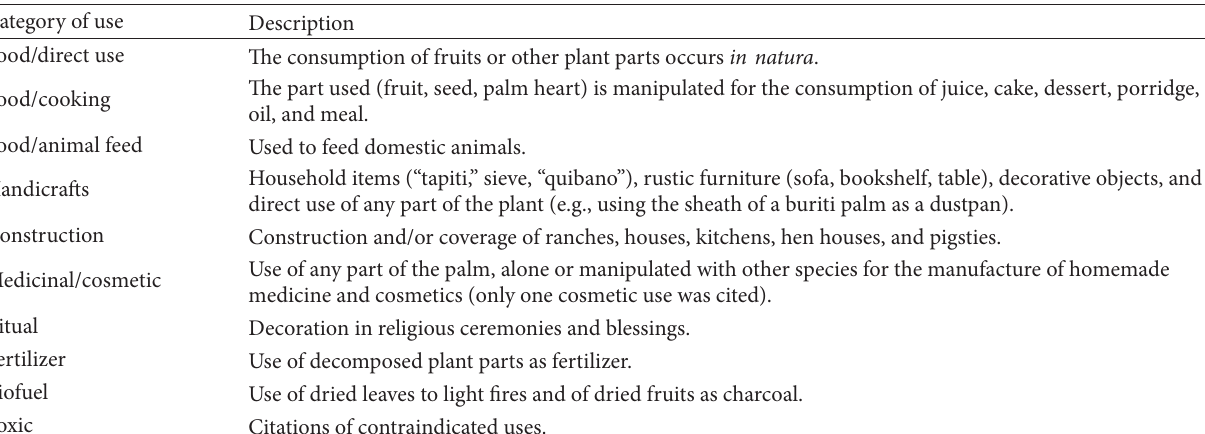
Table 2: Descriptions of the 10 categories of use identified for palms in the Kalunga community Engenho II, Cavalcante, GO, central western Brazil.